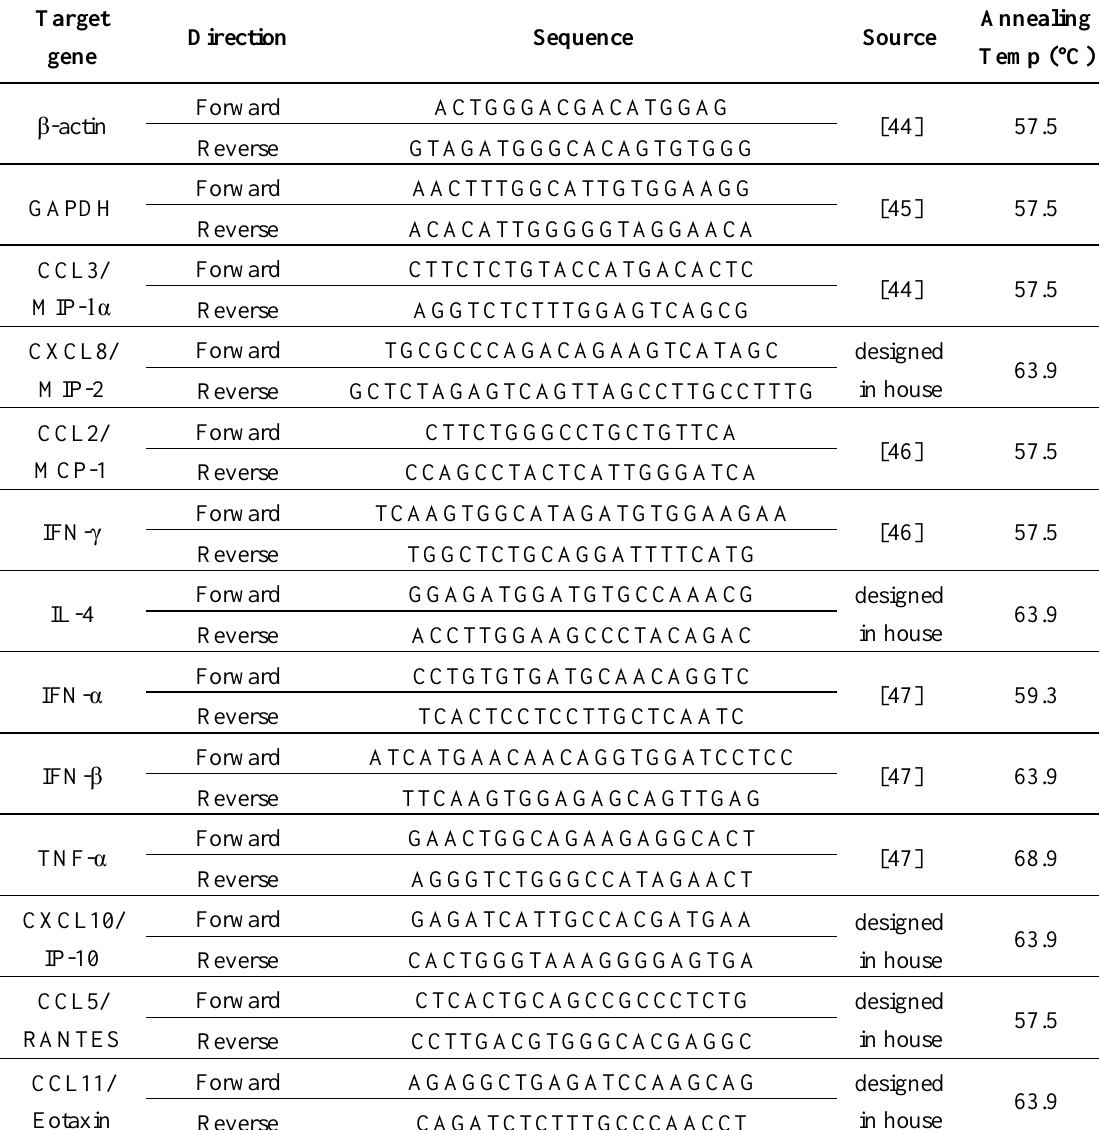
Table 1. Cytokine and Chemokine Primers and their Optimal Annealing